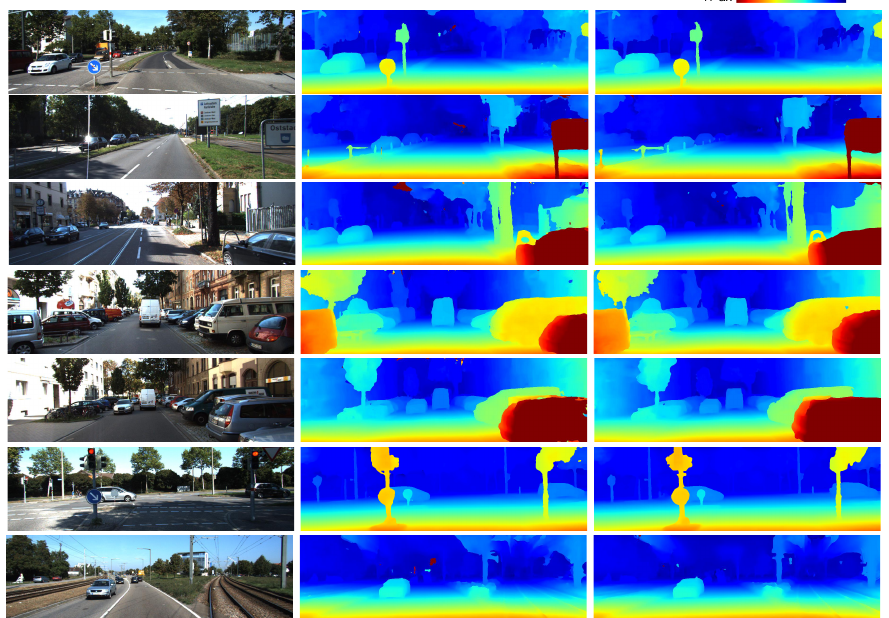
Figure 8. Disparity estimation using KITTI2015. Left : input reference image; middle : disparity results generated by GANet; and right : disparity results generated by